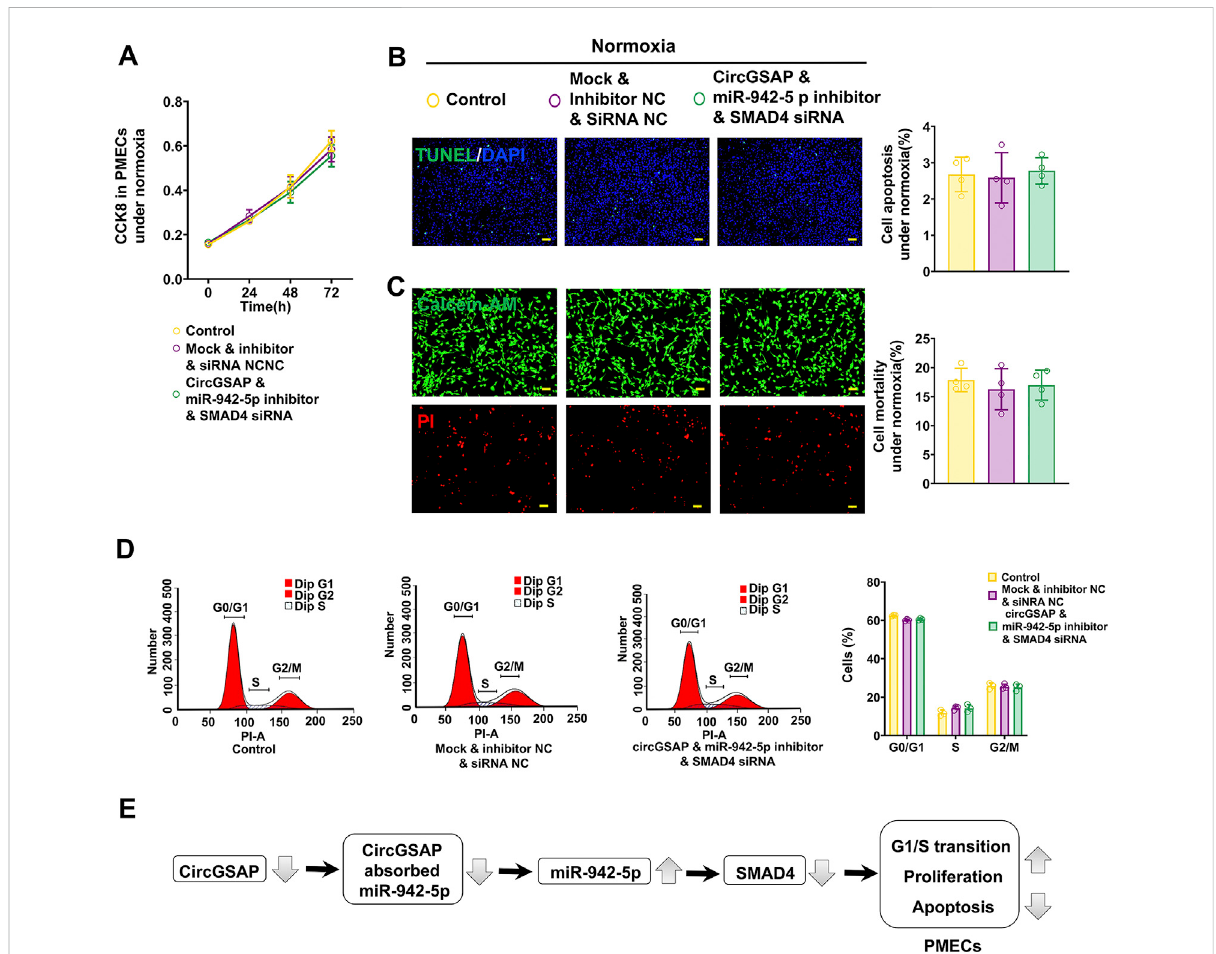
FIGURE 7 CircGSAP/miR-942-5p/SMAD4pathwayeffecttheproliferation,apoptosis,andcellcycleonPMECs. (A – D) Cellproliferationanalysis,apoptosis analysis, mortality analysis ( n = 4) and cell cycle analysis ( n = 3) of PMECs with co-transfecting circGSAP, miR-942-5p inhibitor and SMAD4 siRNA under normoxia. (E) A schematic diagram to illustrate the hypothetical model. All data are presented as the mean ± SEM. (scale bar, 100 μ m). * p < 0.05; ** p < 0.01; *** p <